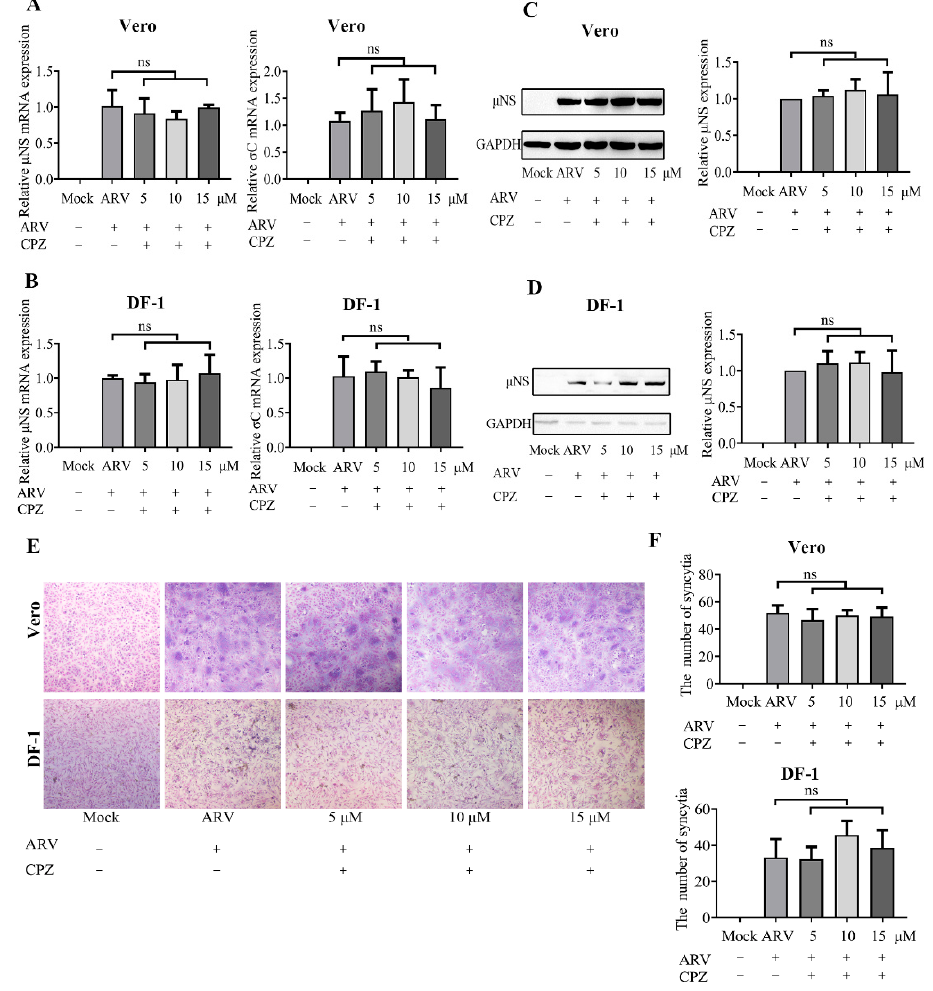
Figure 5. Clathrin is not required for ARV entry. Vero and DF-1 cells were pretreated with the indicated concentrations of CPZ (5, 10, 15 µ M) for 1 h and incubated with ARV (10 MOI) for 1 h at 37 ◦ C. The bound but unpenetrated virions were inactivated with citrate buffer. ( A ) The mRNA expression levels of the ARV- µ NS and σ C genes in Vero cells were determined by qRT-PCR at 9 hpi. ( B ) The mRNA expression levels of the ARV- µ NS and σ C genes in DF-1 cells were determined by qRT-PCR at 9 hpi. ( C , D ) The level of ARV µ NS protein in Vero ( C ) and DF-1 ( D ) cells was analyzed by Western blotting at 9 hpi. ImageJ software was used to analyze the relative levels of µ NS protein in comparison with ARV group that without drug treatment, and the ratios from three independent experiments are displayed as fold changes in the histograms. ( E ) The level of syncytium formation in Vero and DF-1 cells was detected by Giemsa-staining at 12 hpi. Images were captured on an inverted microscope at 10× objective. ( F ) The number of syncytia per microscopic field in Vero and DF-1 cells. Results are presented as the means ± SD of data from three independent experiments. ns, not significant.